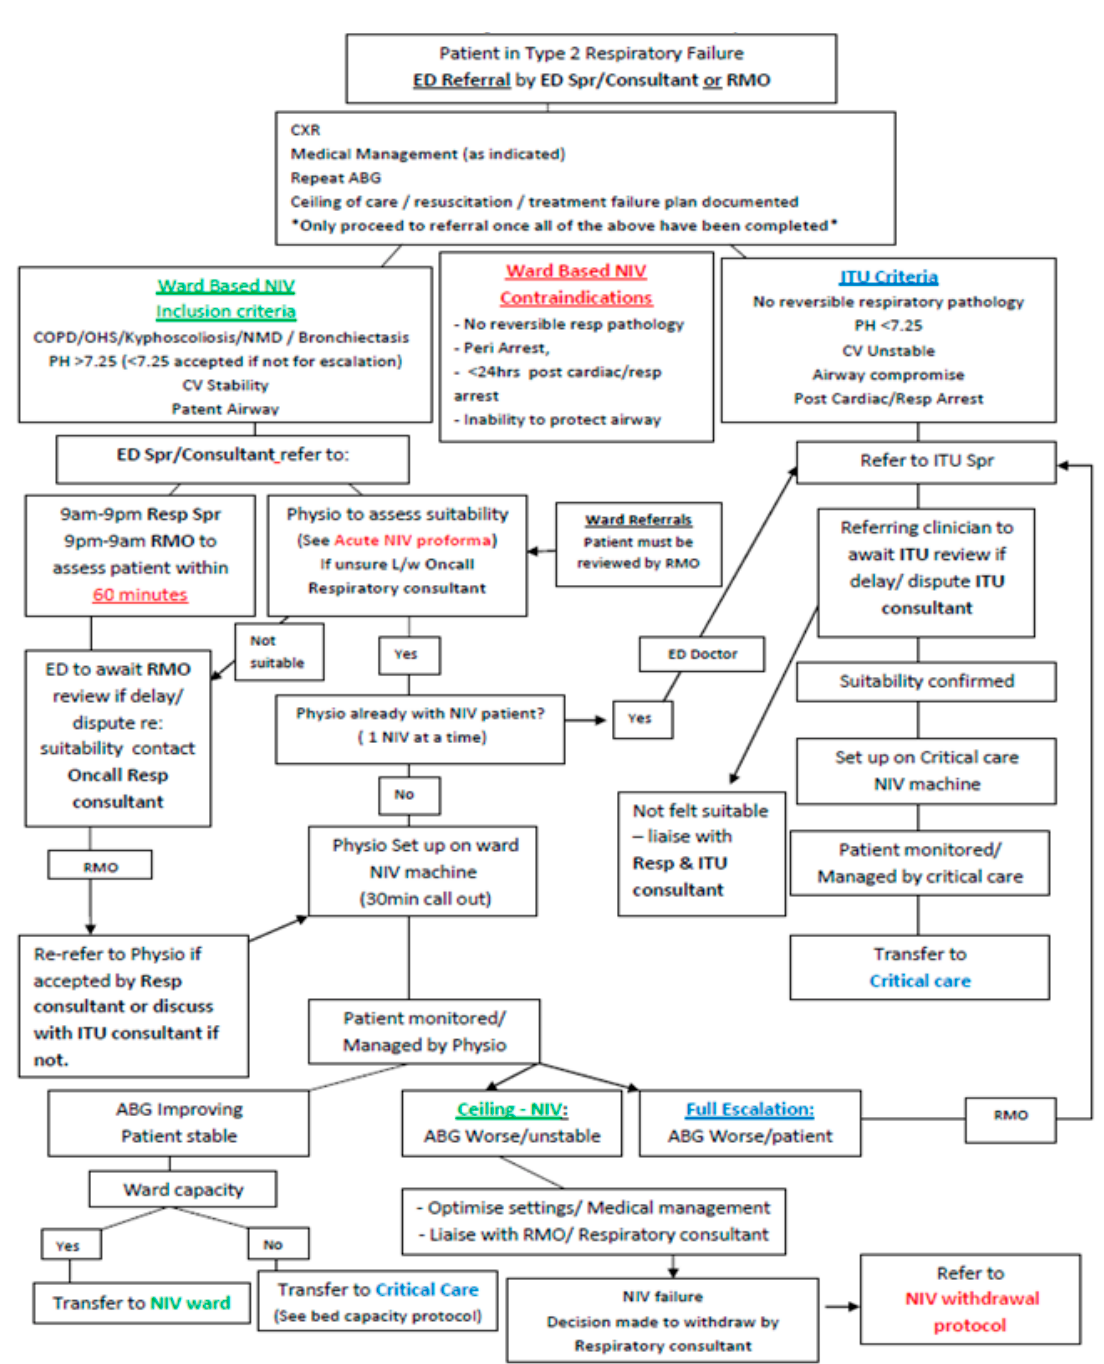
Figure 1. Inpatient acute Non-invasive ventilation (NIV) referral pathway.